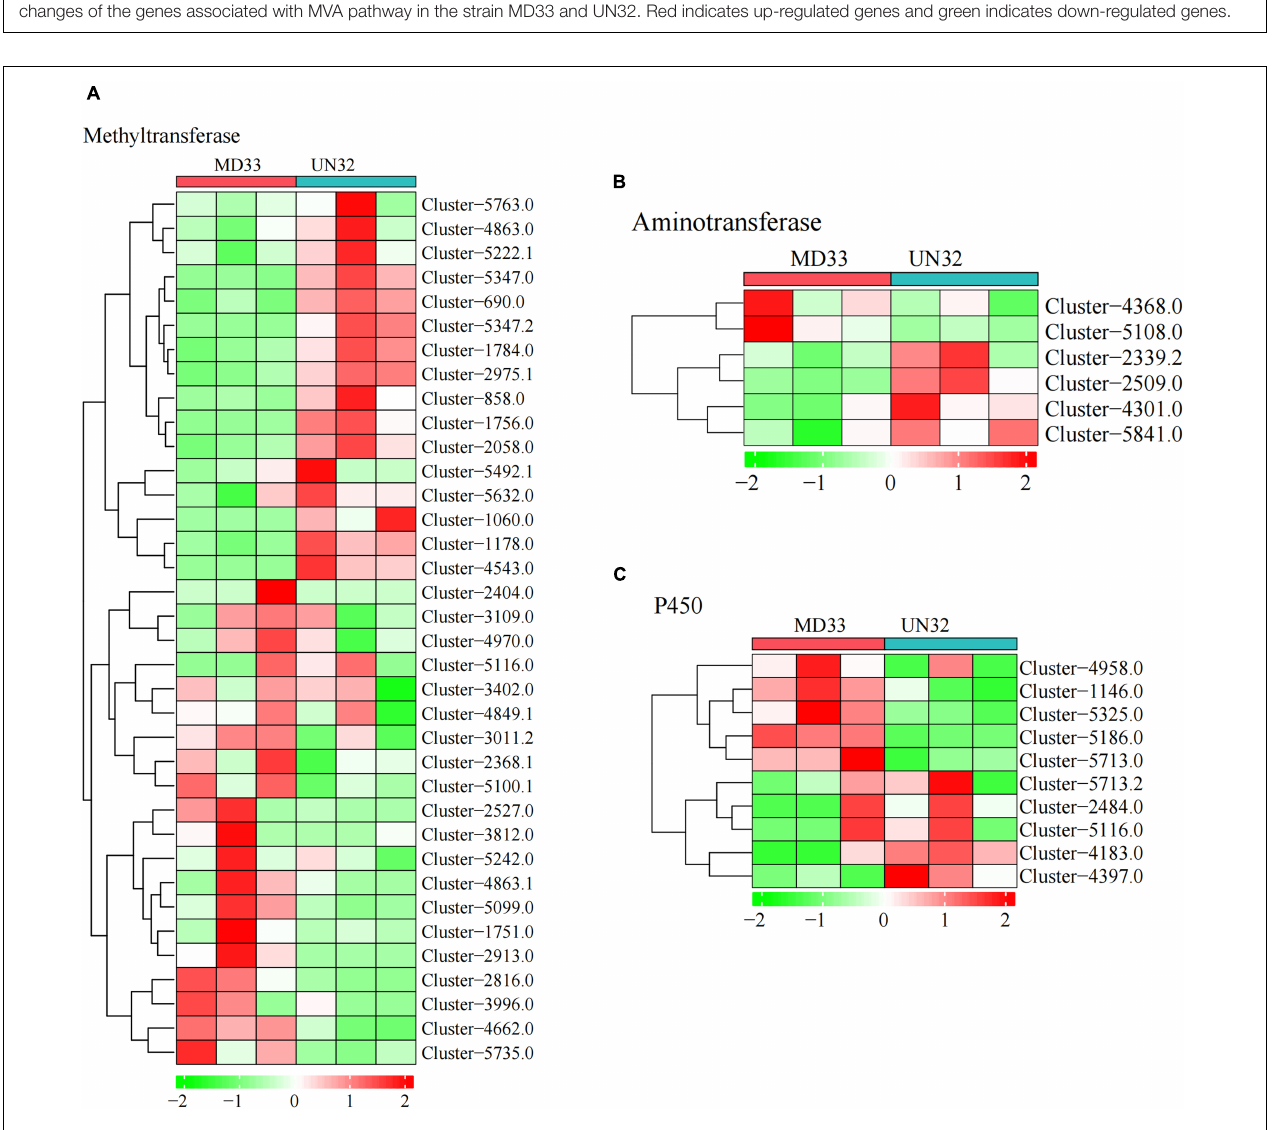
FIGURE 4 | Heat map analysis of genes in backbone post-modification. (A) Heat map analysis of methyltransferases. (B) Heat map analysis of aminotransferases. (C) Heat map analysis of Cytochrome P450 family.